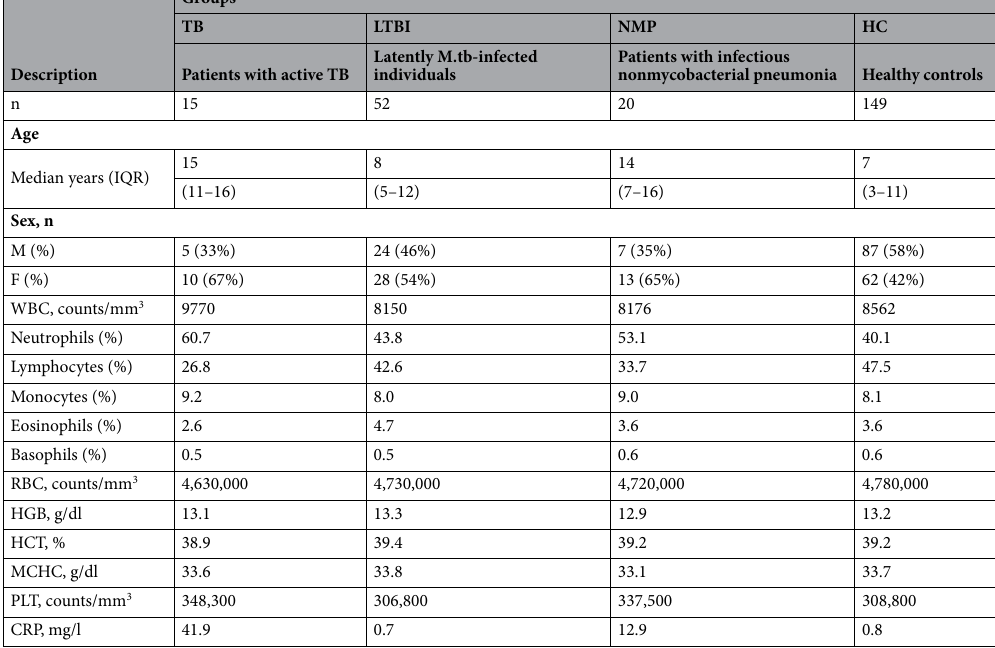
Table 1. Demographic characteristics of study subjects. CRP C-reactive protein, F female, HCT haematocrit, hGB haemoglobin, M male , MCHC men corpuscular haemoglobin concentration, M.tb Mycobacterium tuberculosis , n number, PLT platelets, RBC red blood cells, SD standard deviation, TB tuberculosis, WBC white blood